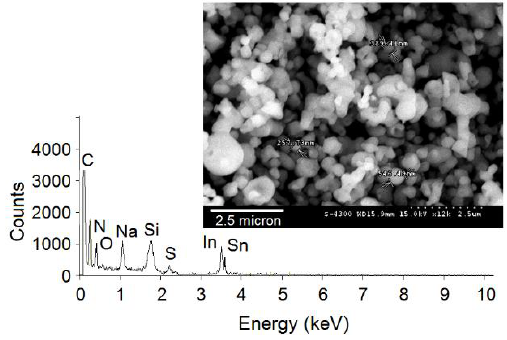
Figure 2. FE-SEM and EDX analysis of the solution obtained after the leaching step on scrap ITO substrates.